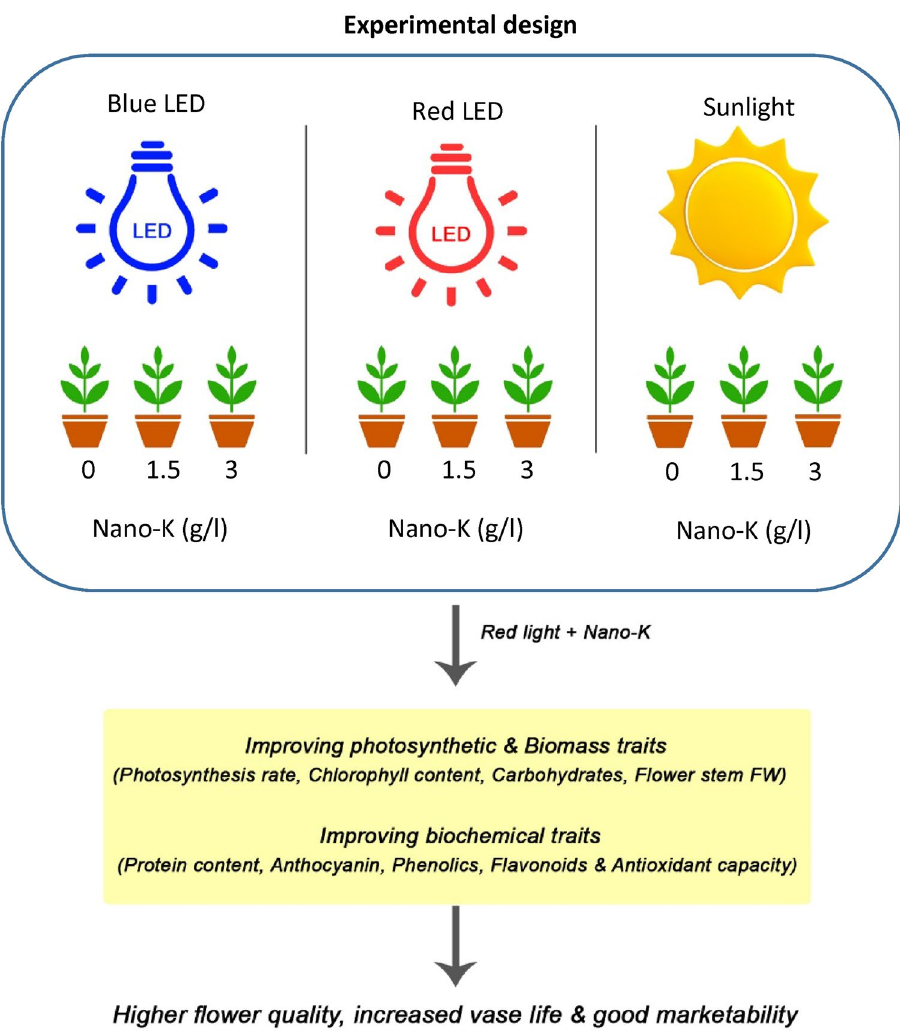
Figure 4. A schematic work model of experimental design and